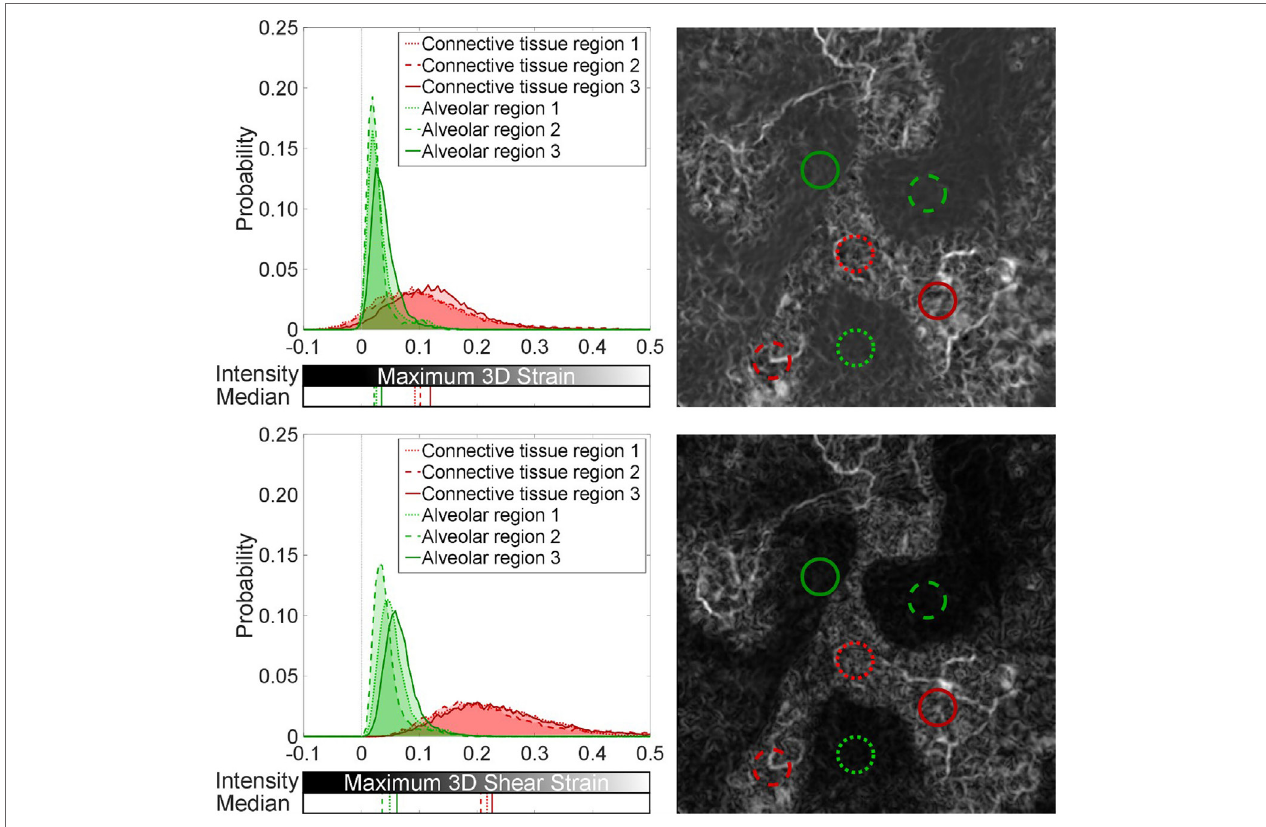
FigUre 5 | Spatial analysis of strain field in the control: (top) maximum three-dimensional strain and (bottom) maximum three-dimensional shear strain. Sub- volumes (0.26-mm radius) within the control specimen were analyzed to highlight uniform low-level strains in alveolar regions (green) and a dense network of higher strains in connective tissue between lobular regions of alveoli (red). The median for each distribution is also